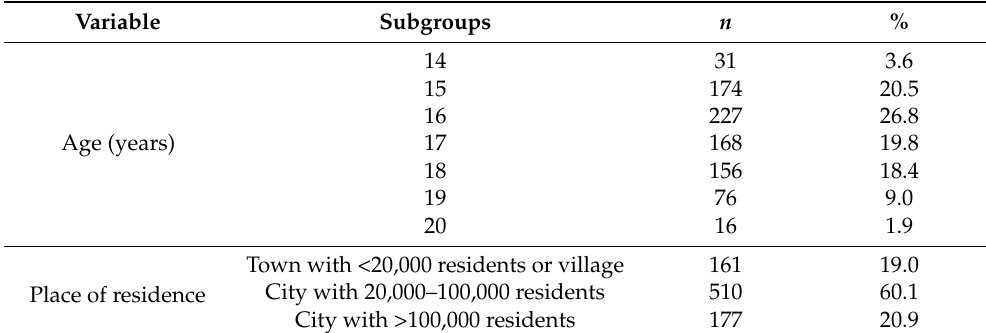
Table 1. The general characteristics of the group of Polish female adolescents participating in the study.